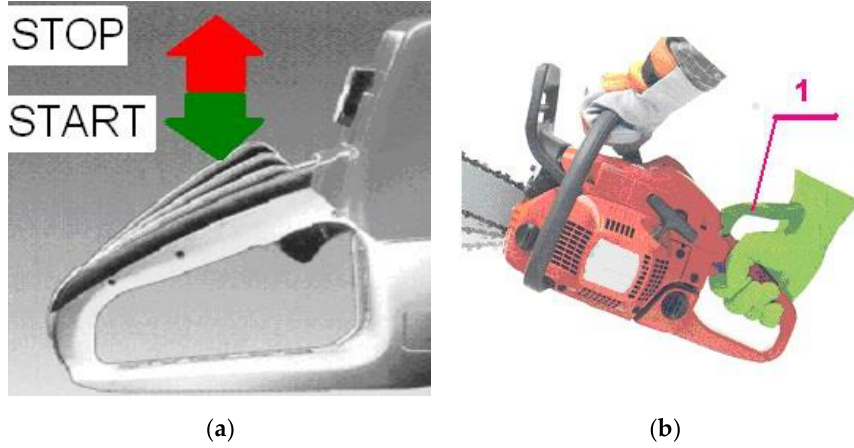
Figure 12. Examples of other ways to activate the chain brake: ( a ) immediately after the operator releases the throttle trigger lock on the portable combustion chainsaw, and ( b ) by moving an additional guard at the rear handle of the chainsaw. 1: additional chain brake activation lever.